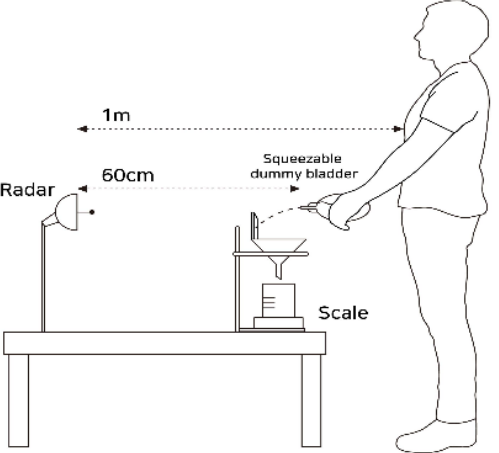
Figure 4. Lateral view of the experimental setup showing the position of the human target and the squeezable dummy bladder.